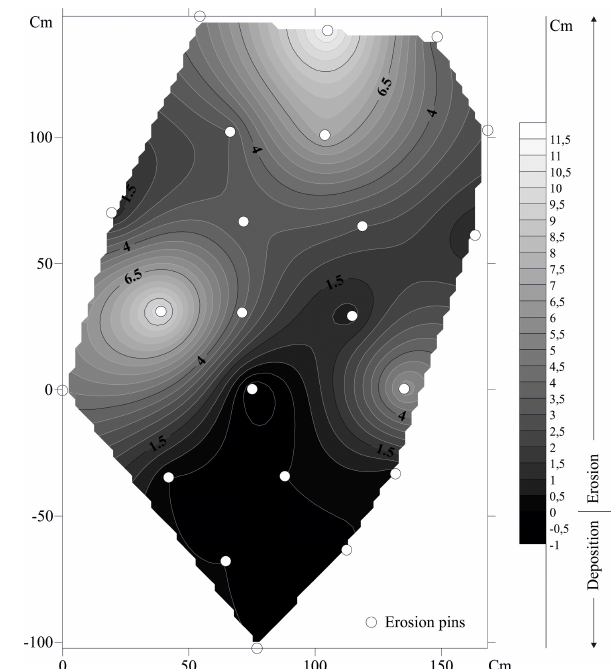
Figure 4. Example map of the channel bank morphology changes.